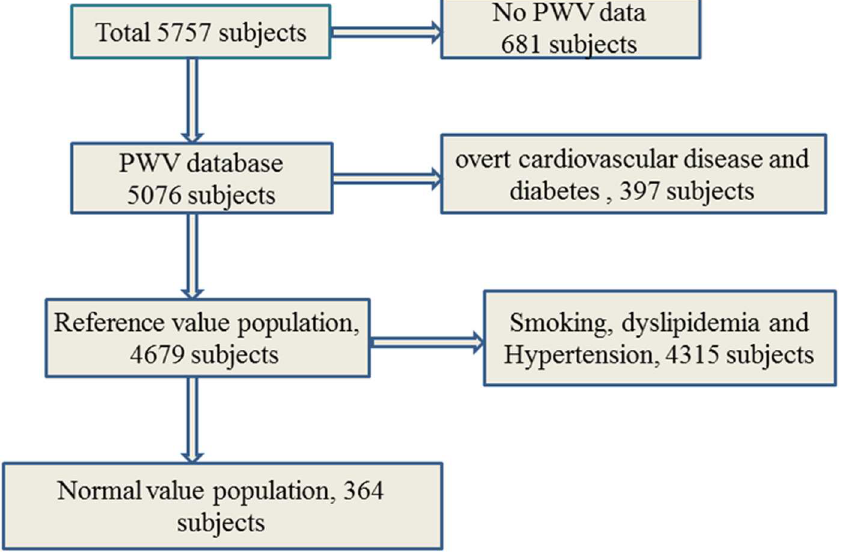
Fig 2. Flowchart describing the selection and categorization of subjects from the referencevalue database for the present